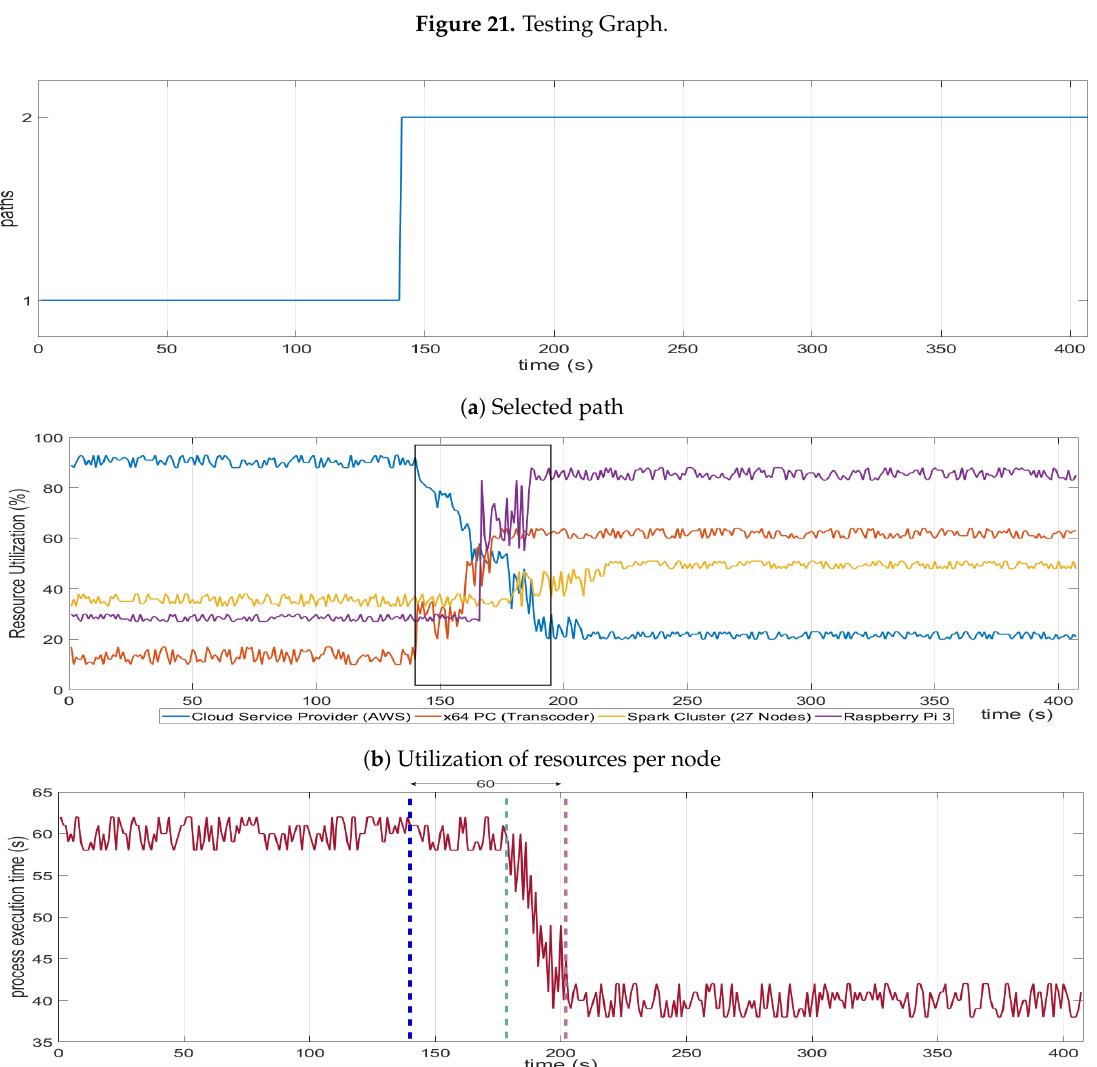
Figure 21. Testing Graph.